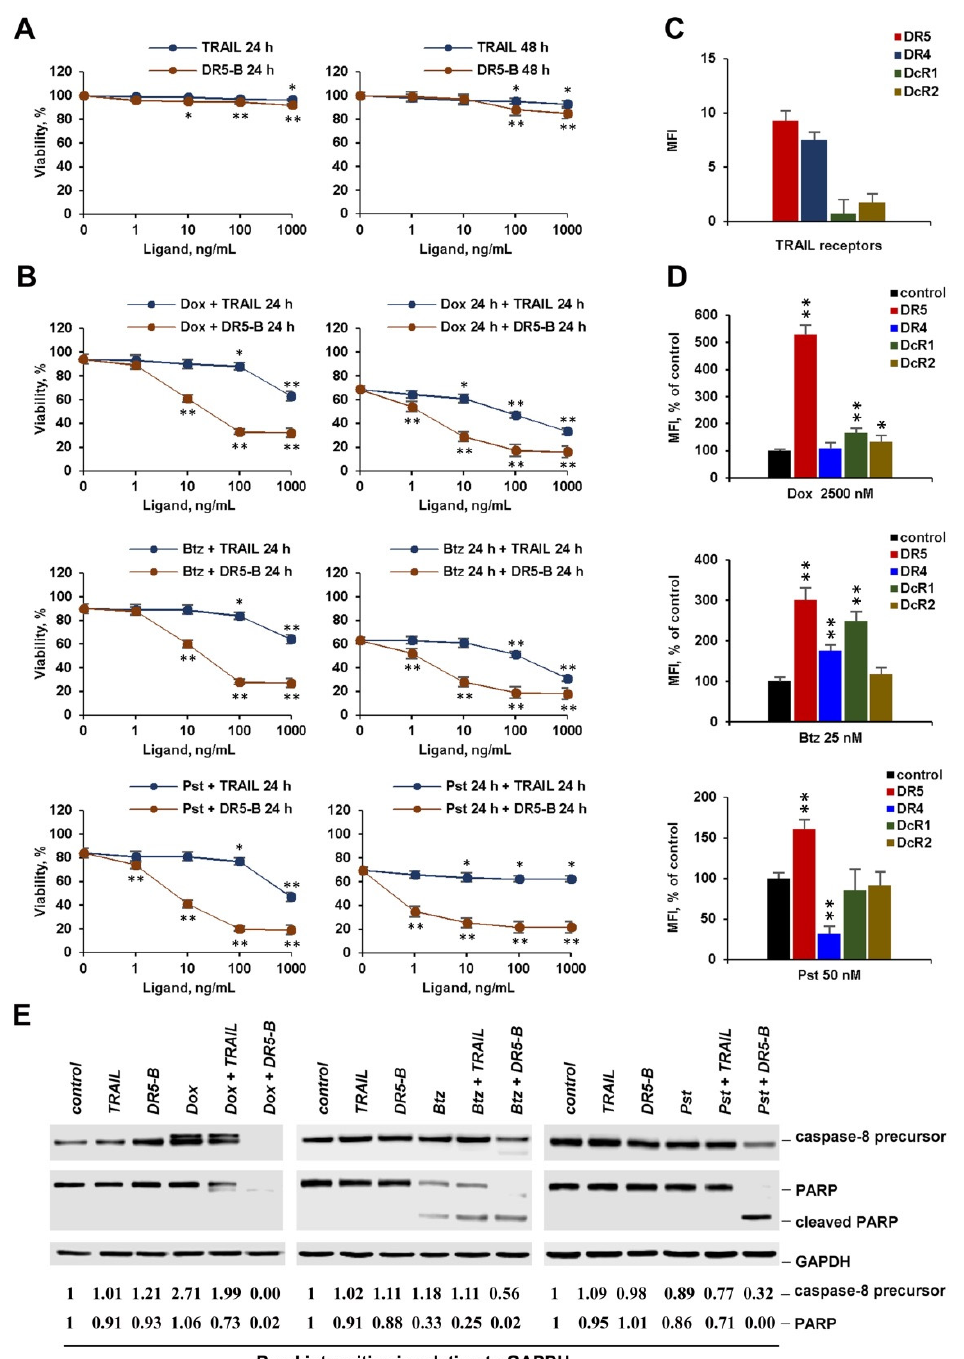
Figure 5. Chemotherapeutic agents at low concentration sensitize HT-29 cells to DR5-B more effectively than TRAIL. ( A ) Cells were treated with TRAIL or DR5-B for 24 h and 48 h. ( B ) Cells were either treated with TRAIL or DR5-B in combination with 2500 nM doxorubicin (Dox), 25 nM bortezomib (Btz) and 50 nM panobinostat (Pst) for 24 h or pretreated with chemotherapy for 24 h, by addition of TRAIL or DR5-B for another 24 h. Cell viability was quantified by Wst-1 assay. Surface expression of death and decoy receptors before ( C ) and after treatment ( D ) with chemotherapy at indicated concentrations determined by flow cytometry. Mean ± Standard Deviation ( n = 3). The asterisks indicate significance (* p < 0.05) and (** p < 0.001) relative to cells treated with chemotherapy without ligands. ( E ) Cells were pre-incubated with chemotherapy for 16 h, followed by 1000 ng/mL ligands for another 6 h for Dox and Pst and 3 h for Btz. Cleavage of caspase-8 and PARP proteins was